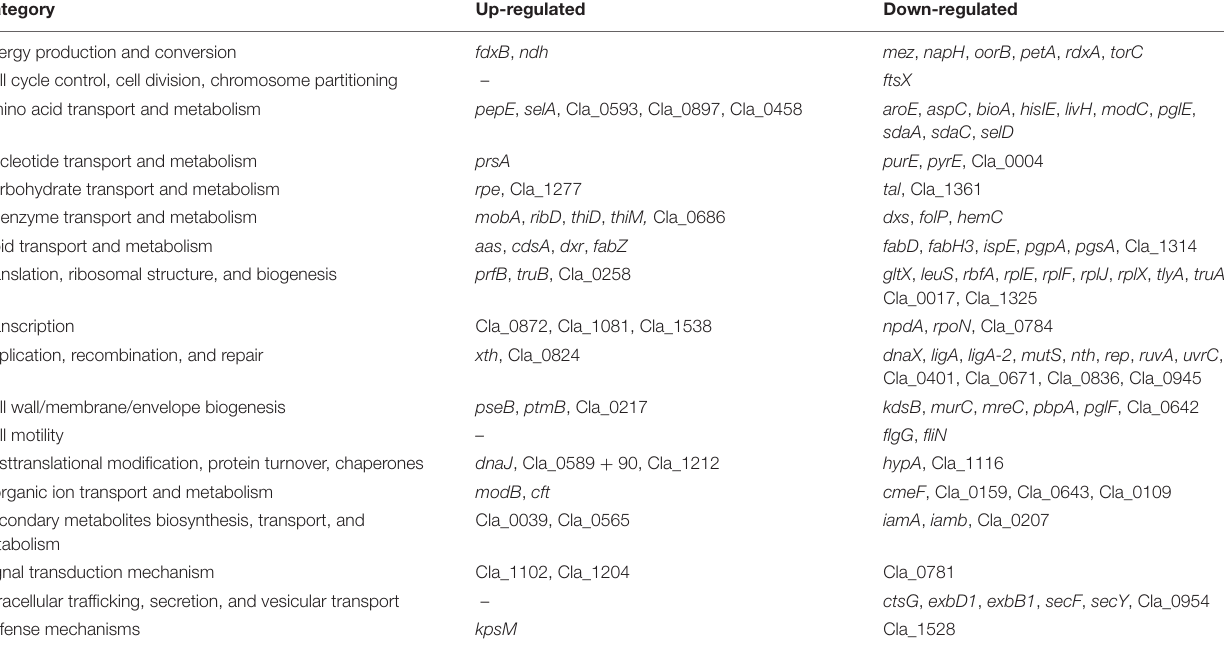
TABLE 4 | Genes differentially regulated after heat stress in C. lari RM2100 only.